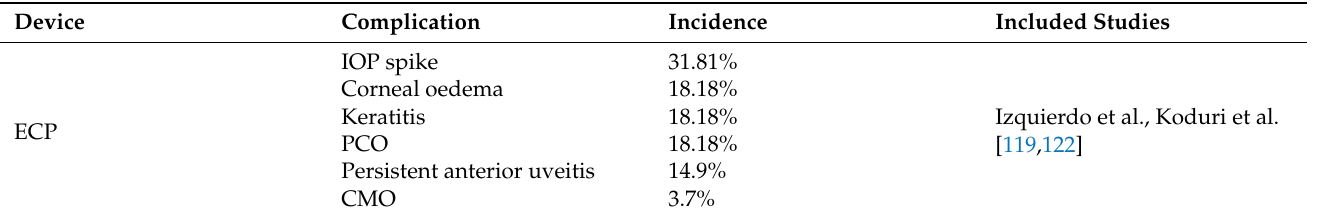
Table A4. Complication Rates of Device Reducing Aqueous Production by Ciliary Body